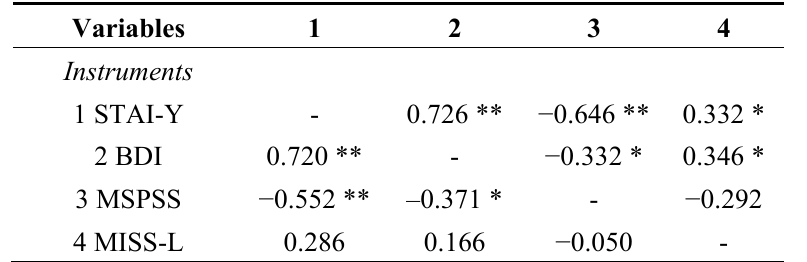
Table 5. Bivariate Pearson correlations among the instruments, in the two lesbian populations: the superior triangle refers to the Italian participants ( N = 43), the inferior triangle to the Belgian participants ( N =